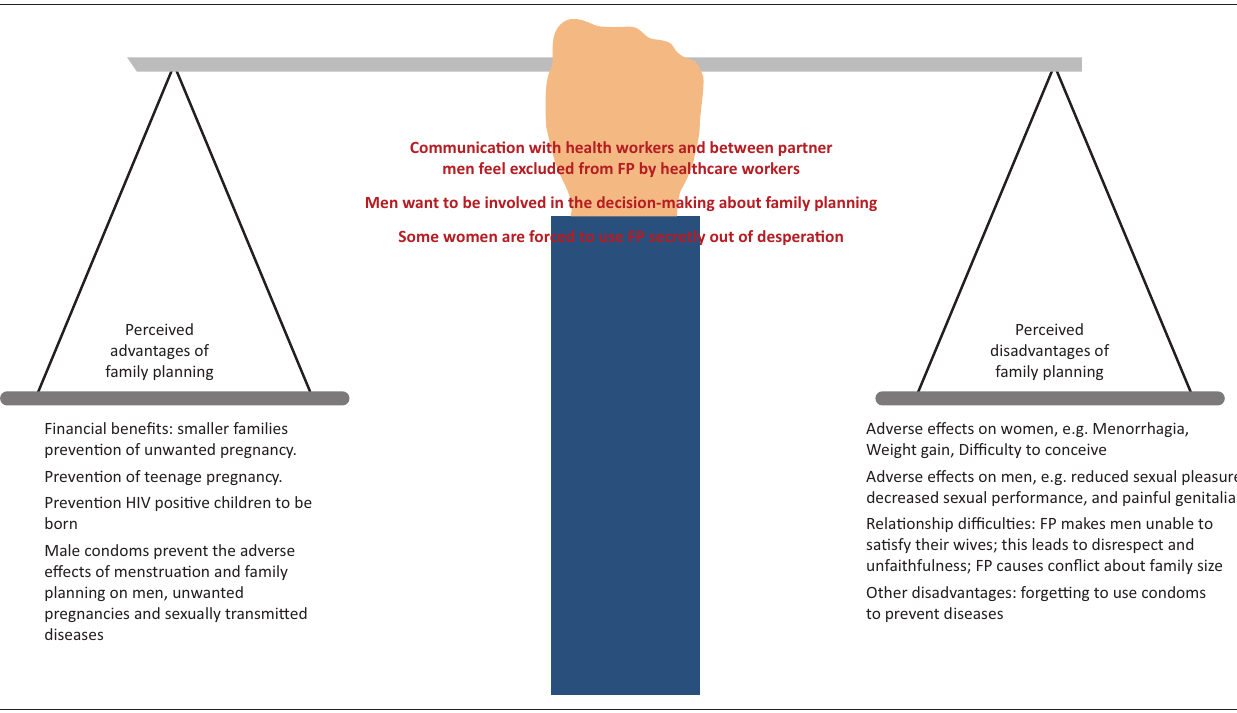
FIGURE 1: Diagrammatic depiction of the three major themes and subthemes: a balanced scale with the perceived advantages of family planning (FP) on the one side and the perceived disadvantages of FP on the other. The third major theme is communication with men about FP, which is depicted as the central arm of the scale.